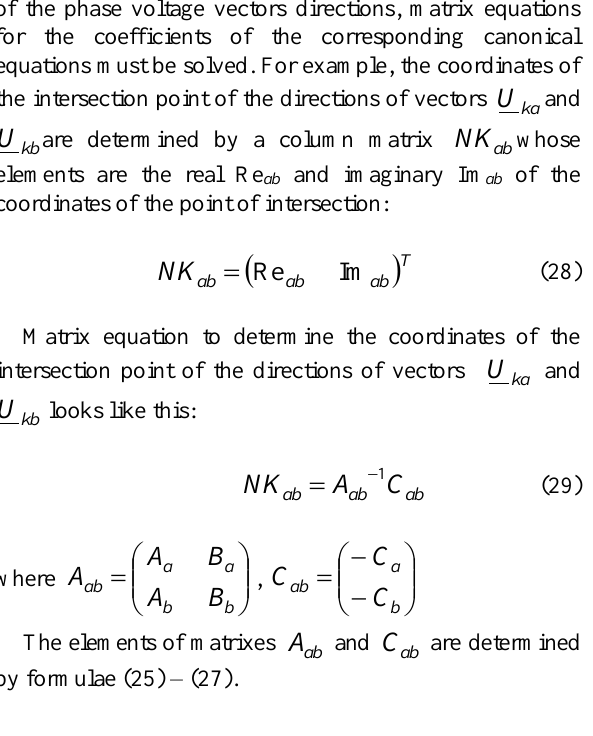
Table 3. Diagram-analytical Mathcad-calculation of potential of a neutral point and phase resistances of the balancing device in Figure 2 according to formulae (24) –